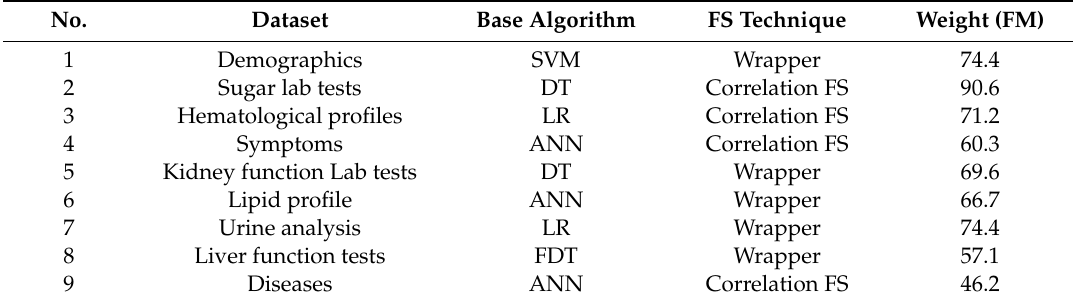
Table 4. The proposed ensemble classifier’s base algorithms and their